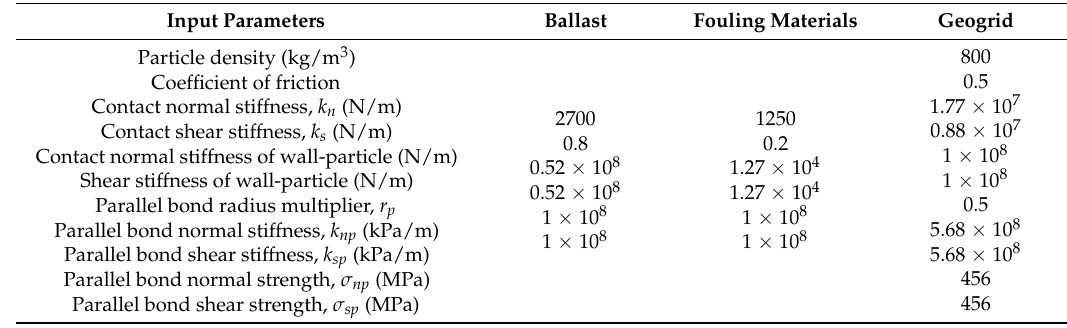
Figure 15. Shear stress-strain responses and volumetric changes of geogrid-reinforced ballast: ( a ) fresh ballast; ( b ) fouled ballast (data source: Ngo et al. [31]). Table 6. Micro-mechanical input parameters used in the DEM analysis (Ngo et al. [31]).